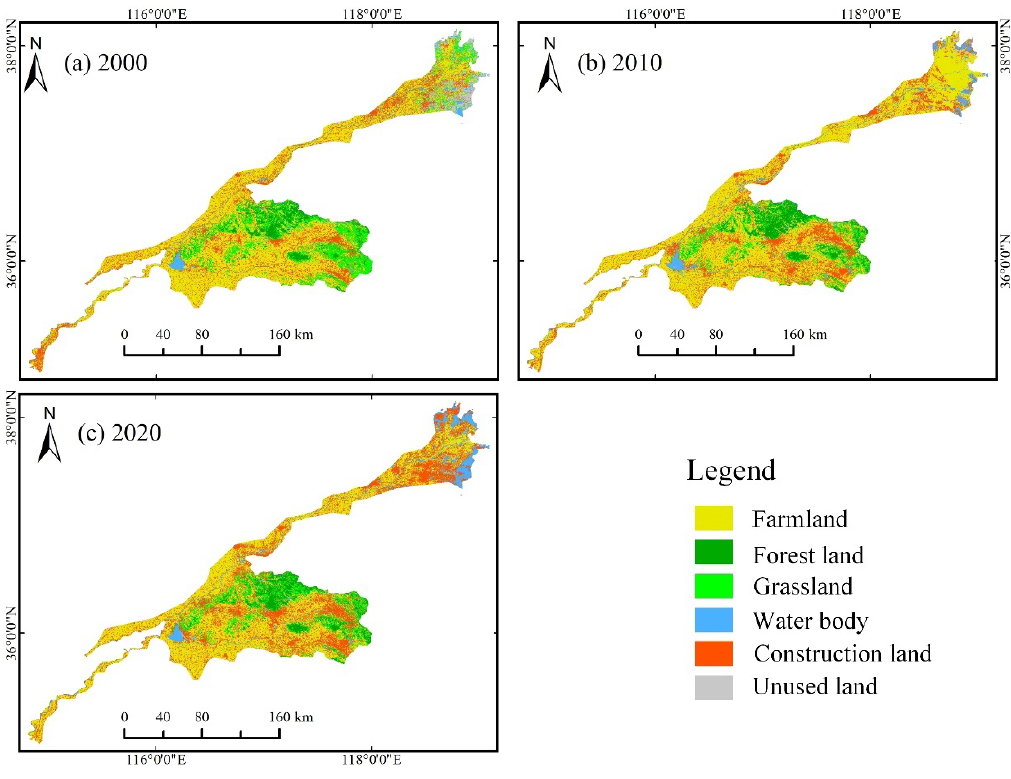
Figure 5. Spatial distribution map of LULC in the study area from 2000 to 2020, ( a ) 2000; ( b ) 2010; ( c ) 2020.